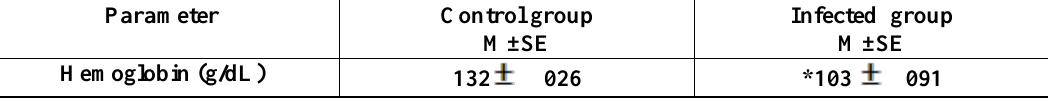
Table (4) Effect of E coli infection on mean of Hemoglobin (Hb) concentration.